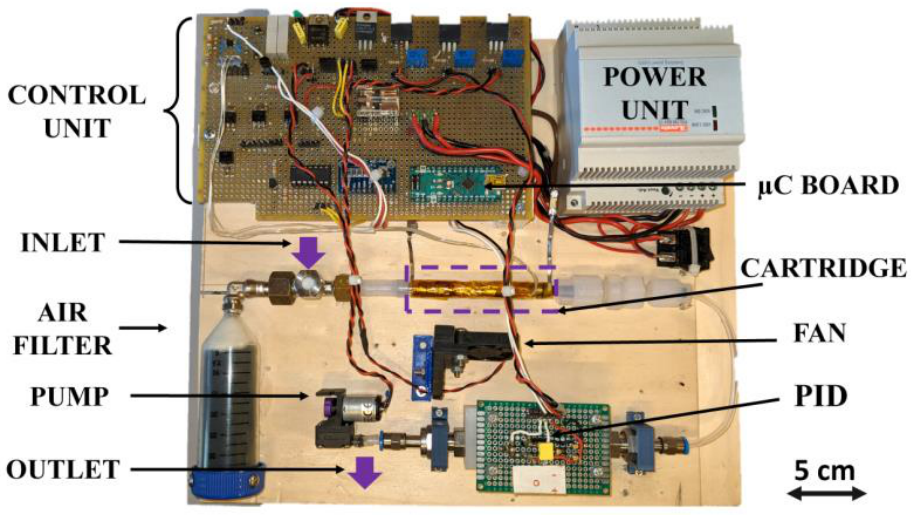
Figure 2. First system prototype.